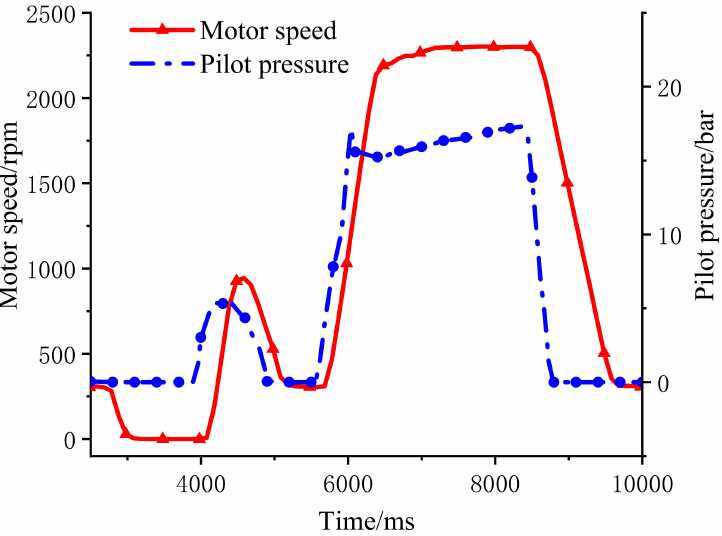
Figure 19. Step response curve of the electric motor speed with pilot pressure.